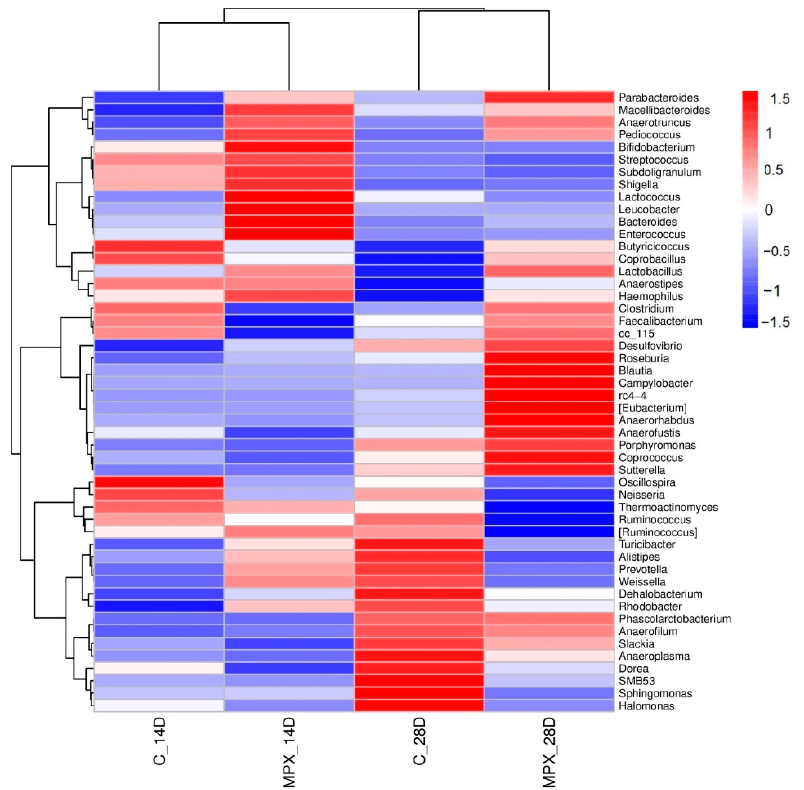
Figure 7. Heatmap analysis of the abundance of intestinal flora.